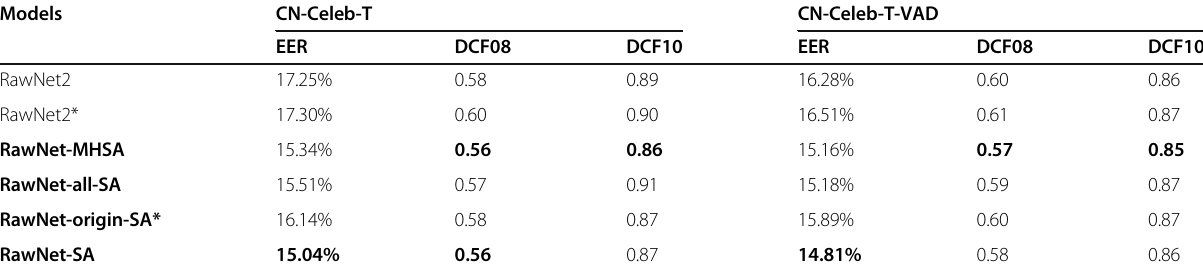
Table 7 The effect of VAD and speech separation Models